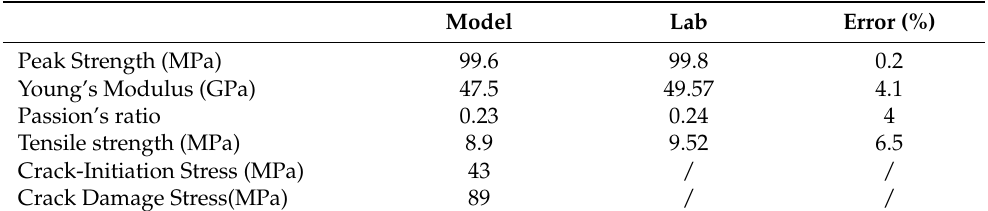
Table 4. Error comparison between numerical model results and experimental results.